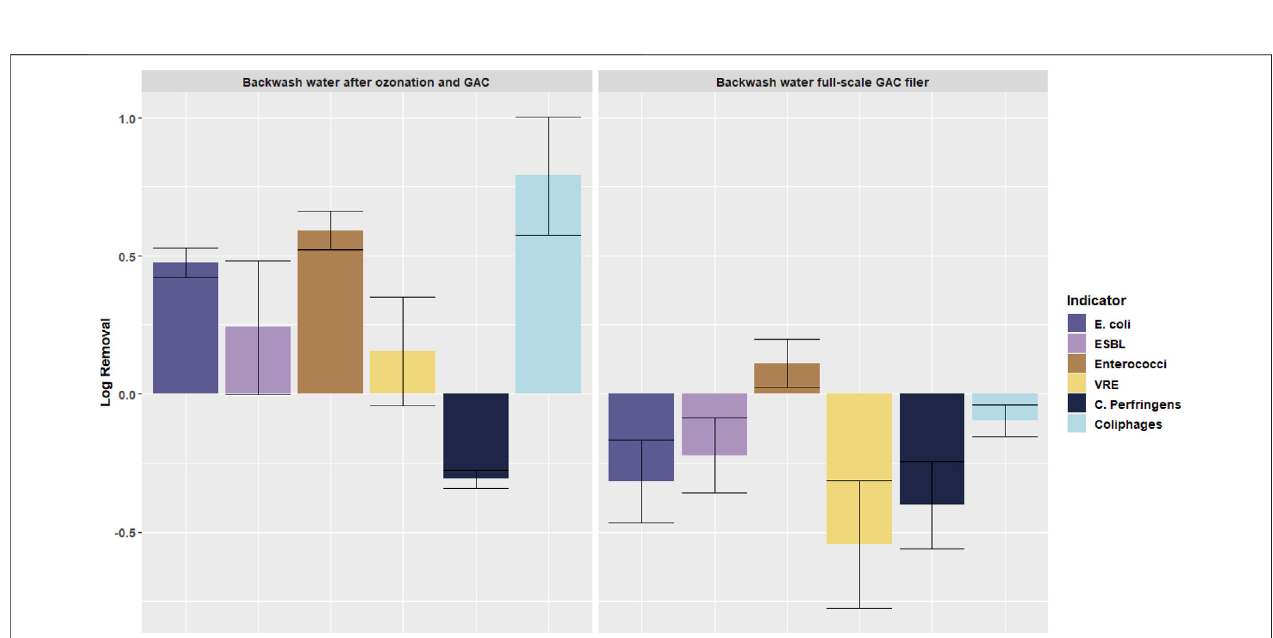
FIGURE 7 | increase and decrease of microorganisms in the backwash water of the GAC fi lter of the pilot plant (location D) and the GAC fi lter of the full-scale plant (location E) related to the concentrations in the secondary ef fl uent (location A). Error bars indicate standard deviation.